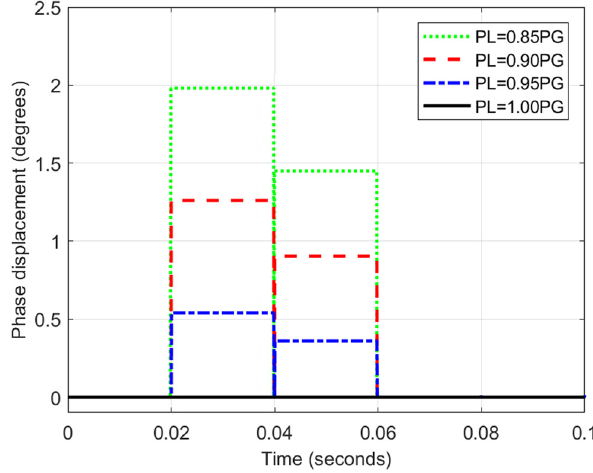
Figure 10: Phase displacement signal at output of the vector shift relay